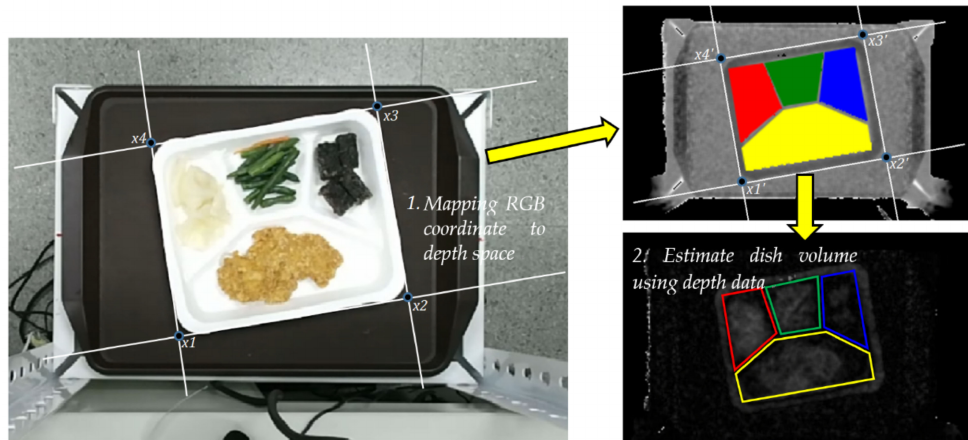
Figure 9. Mapping from RGB coordinate to depth coordinate and estimation of food volumes with depth